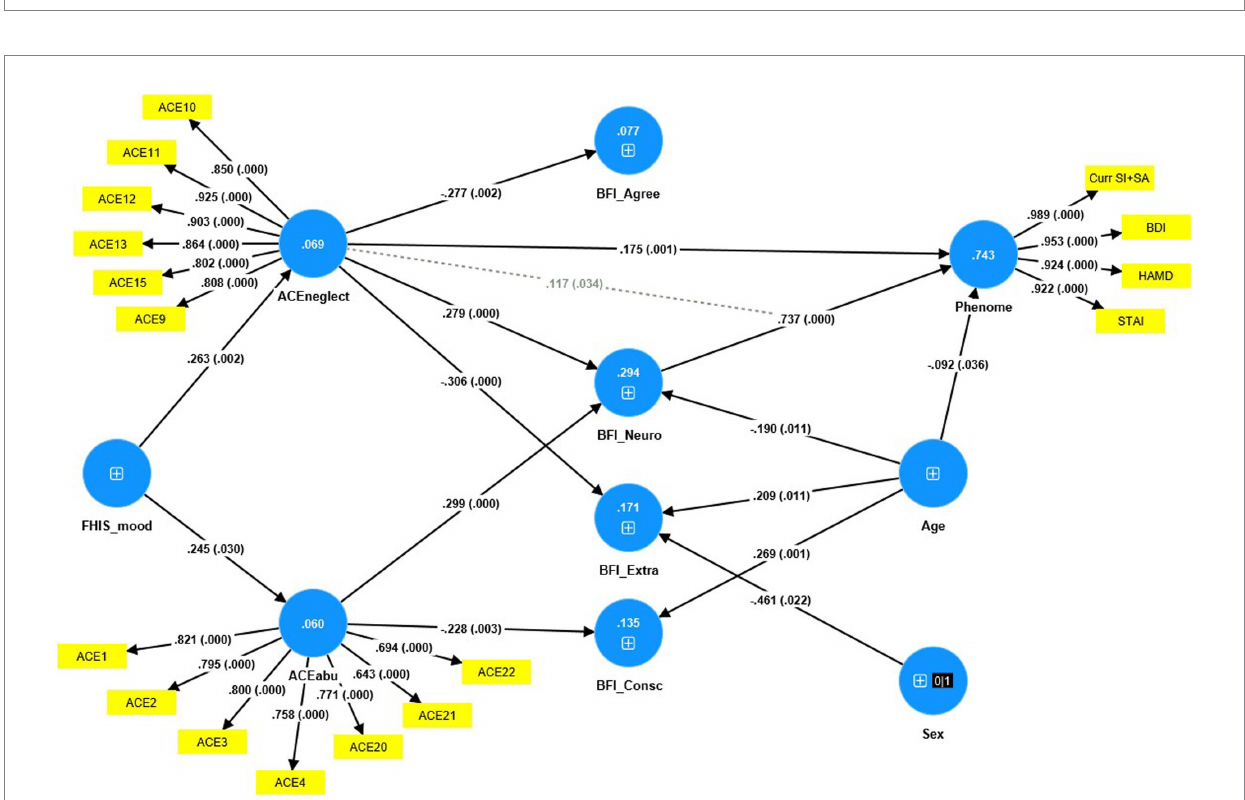
FIGURE 4 Result of PLS analysis. Shown are the significant paths. The Phenome, neglect adverse childhood experiences (ACEneglect) and ACEabuse were entered as latent vectors extracted from their manifestations. The other variables were entered as single indicators (denoted as +); sex was entered as a binary variable (1 = male, 0 = female). Curr SI + SA: current suicidal ideation + attempts; BDI: Beck Depression Inventory; HAM-D, Hamilton Depression Rating Scale; STAI: State and Trait Anxiety Inventory; ACE items: see Supplementary Table S2 for an explanation; FHISmood: a family history of mood disorders and suicidal attempts. BFI, Big Five Inventory; Agree, agreeableness; Neuro, neuroticism; Extra, extraversion; Consc, conscientiousness. Shown are the path coefficients (with exact p -value) of the inner model, and loadings (with p -values) of the outer model; figures in the blue circles: explained